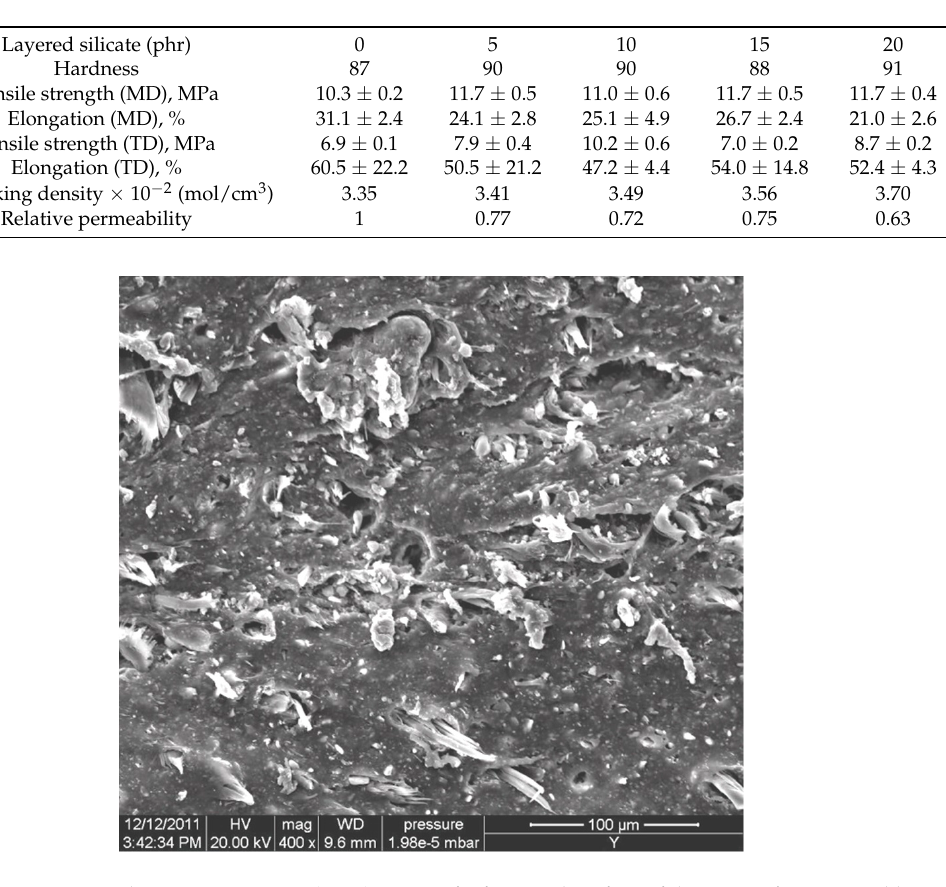
Figure 3. Scanning electron microscopy (SEM) image of a fractured surface of the EPDM/CR nanorubber.